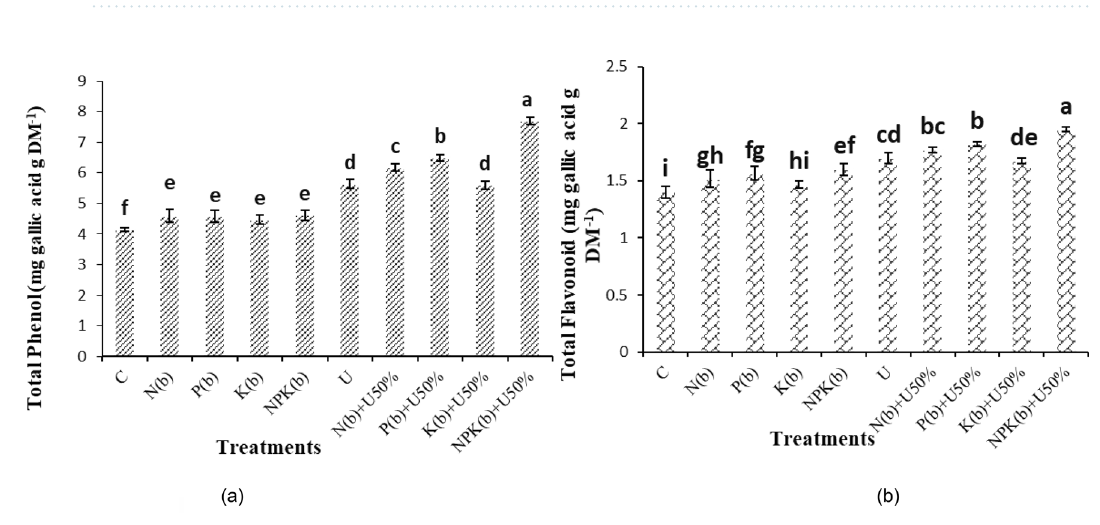
Table 2. The results of analysis of variance for the effect treatment on antioxidants. Ns non-significance; *significance at the p ≤ 0.05 level; **significance at the p ≤ 0.01 level.